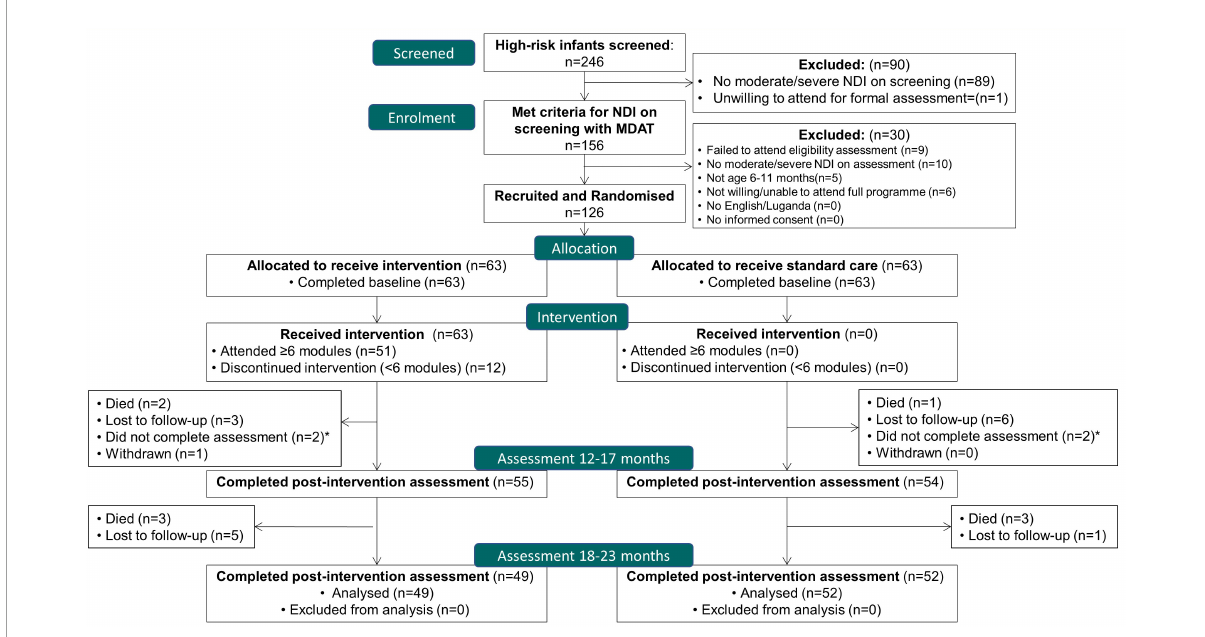
FIGURE2 Flow of participants; CONSORT flow diagram. *Two participants in each arm did not complete the 12–17 month assessment but returned for the 18–23 month